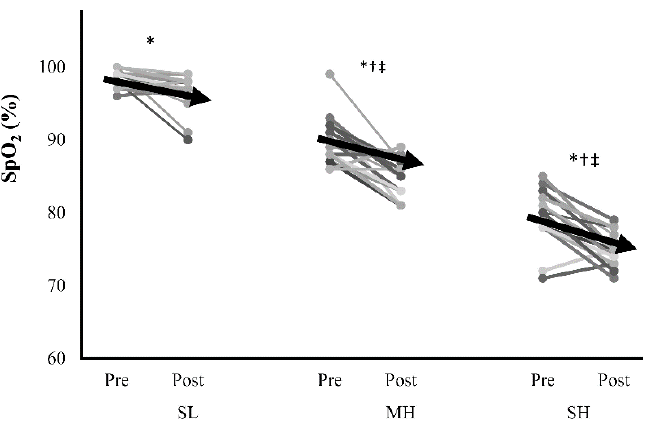
Figure 1. Peripheral oxygen saturation (SpO 2 ) responses to sprint interval training exercise. Arrows are means, and lines present individual responses. SL: sea level; MH: moderate hypoxia; SH: severe hypoxia; PP: peak power; MP: mean power. * Statistically different from the corresponding Pre values ( p < 0.05). † Statistically different from the corresponding SL values ( p < 0.05). ‡ Statistically different from the corresponding MH values ( p < 0.05).